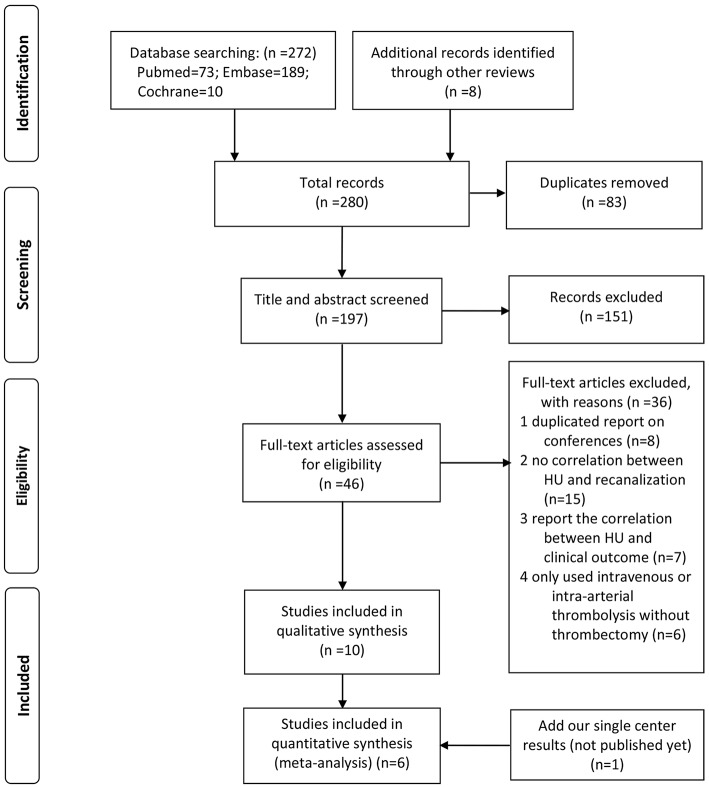
PRISMA flow diagram.